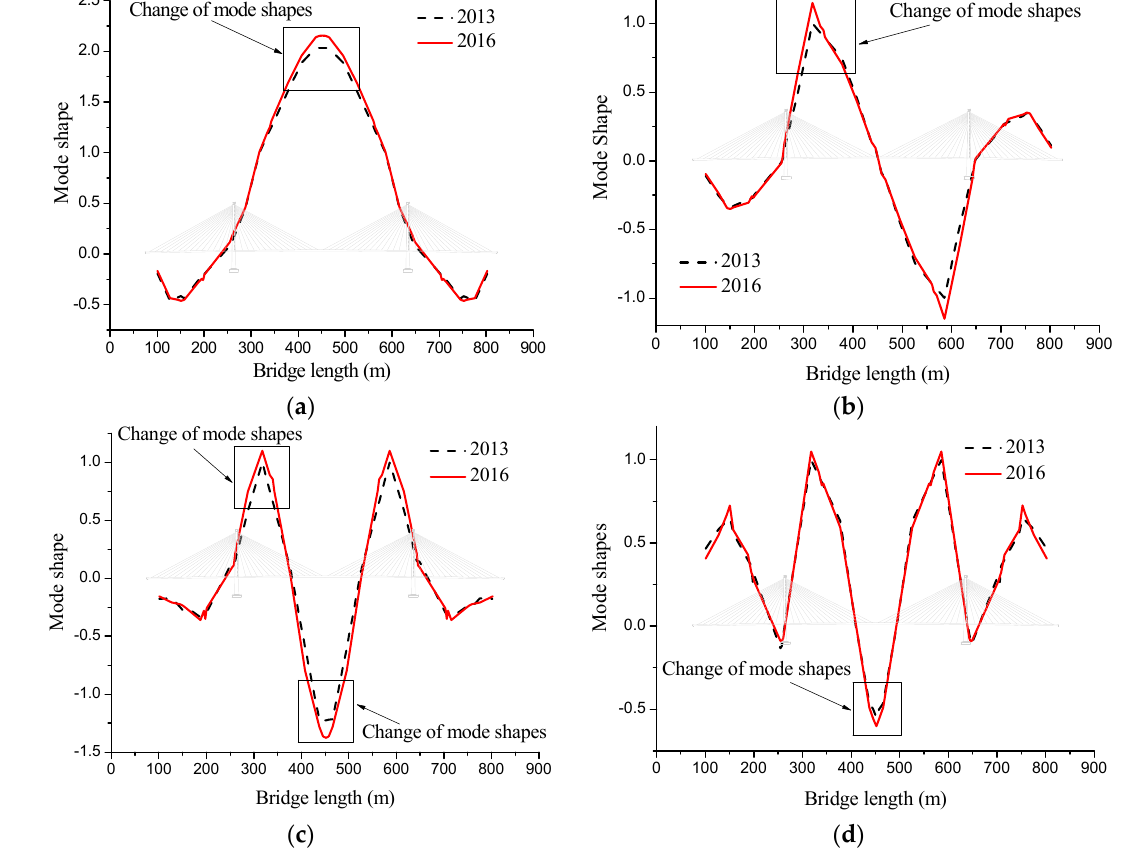
Figure 9. The change of the mode shapes of the girder. ( a ) The 1st vertical bending mode (symmetric), ( b ) The 1st vertical bending mode (antisymmetric), ( c ) The 2nd vertical bending mode (symmetric) ( d ) The 3rd vertical bending mode